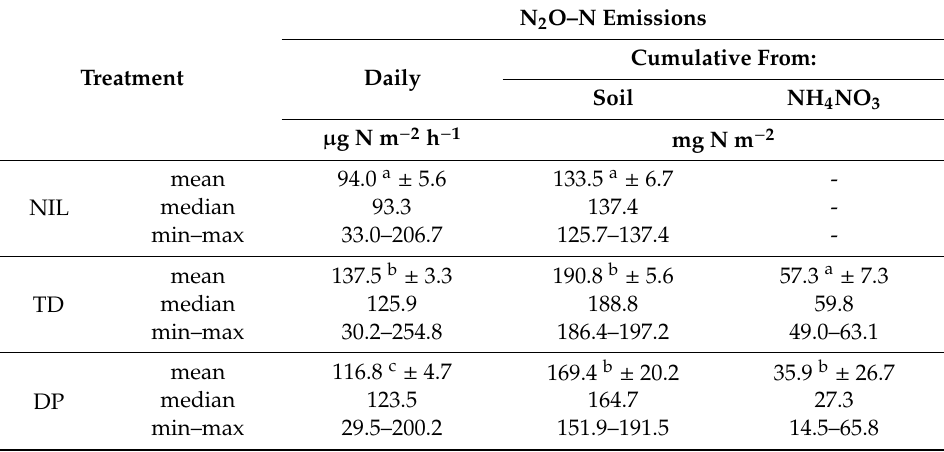
Table 1. Daily N 2 O–N soil emissions and cumulative N 2 O–N emissions from the soil and corrected for background cumulative N 2 O–N emissions from NH 4 NO 3 in the top dressing (TD) and deep placement (DP) fertilization